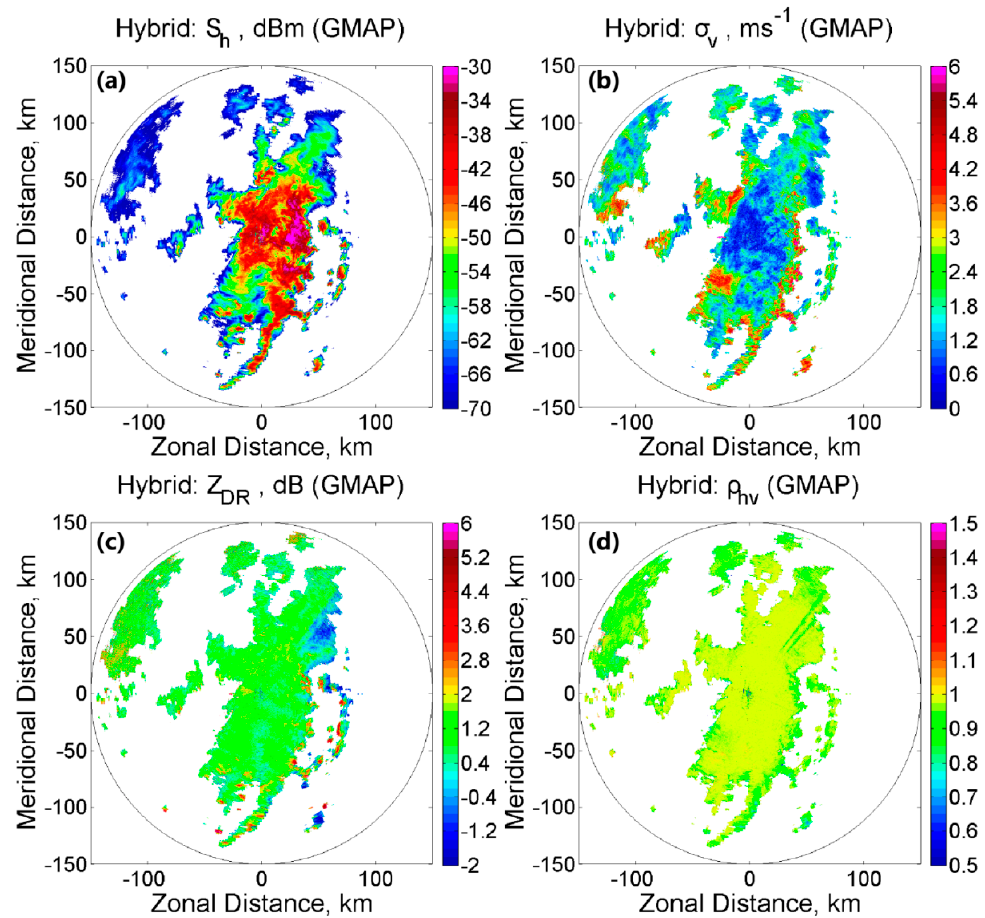
Figure 13. Hybrid estimators for signal power S h , differential reflectivity Z DR , spectrum width σ v, and correlation coefficient ρ hv in the squall line precipitation occurred on 30 July 2014, 1410UTC. ( a ) S h ; ( b ) σ v ; ( c ) Z DR ; and ( d ) ρ hv .